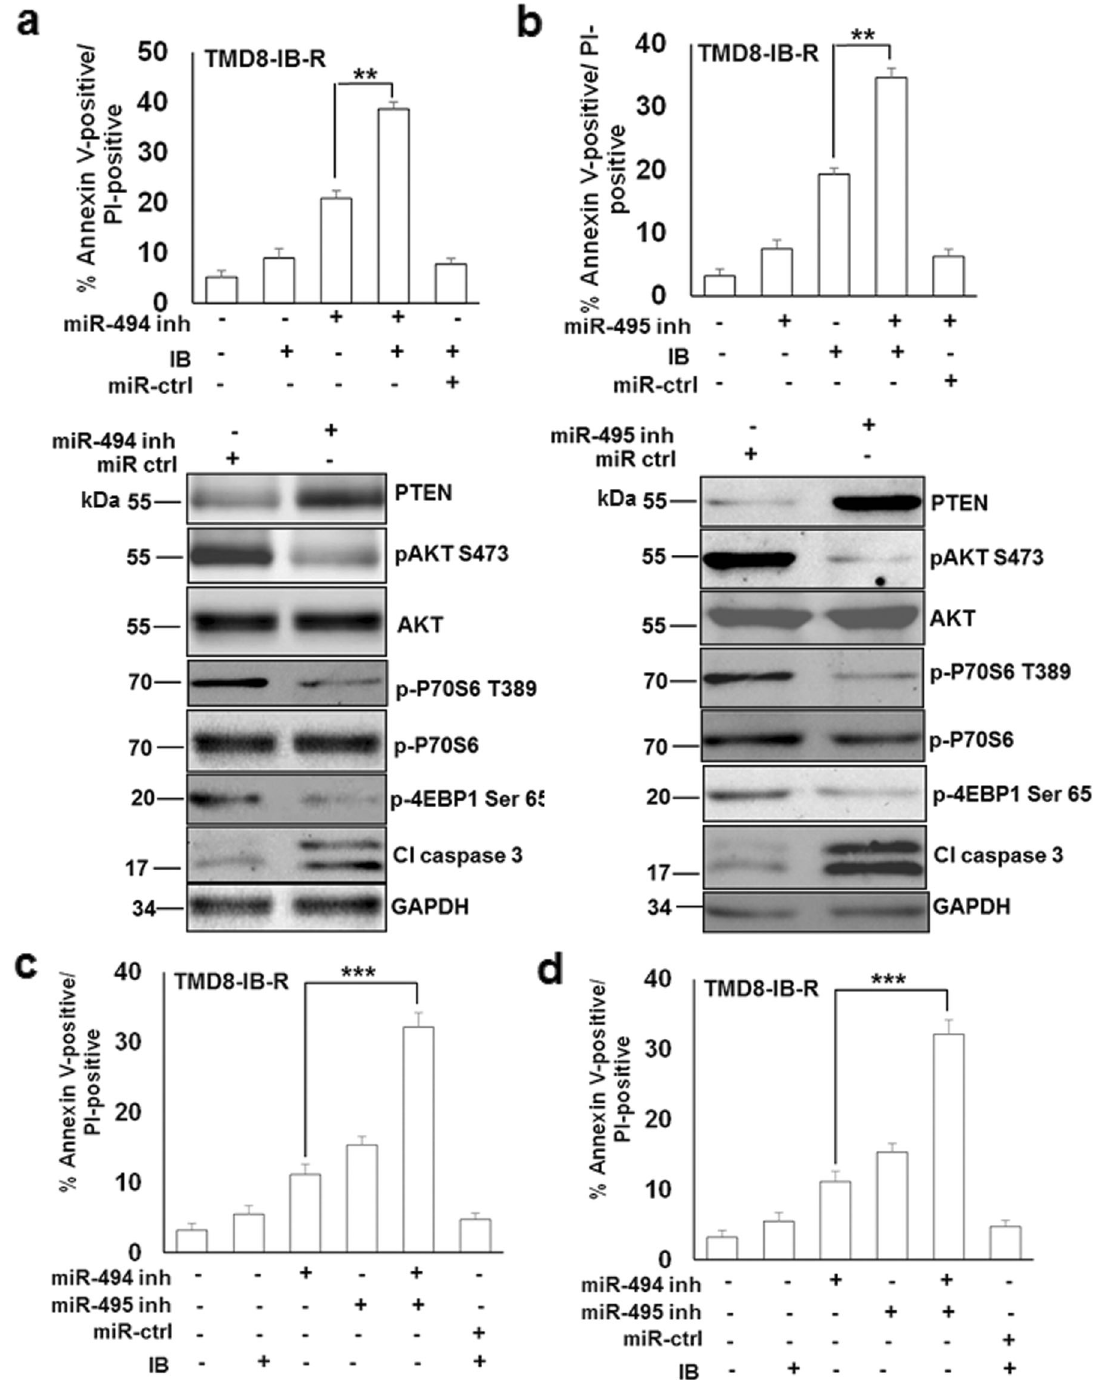
Fig. 6 Cooperative miR-494 and miR-495 inhibition enhances cell survival through AKT/mTOR signaling. a TMD8-IB-R cells were transfected with miR-494 (200 nM) and b miR-495 (100 nM) inhibitors and treated with ± ibrutinib (10 µM) for 24 h. ( Upper panel) Cell death analysis was determined by Annexin V-PI staining. Control cells were treated with DMSO. (**p < 0.01). SD is indicated as error bars ( N = 3). (Lower panel) Expression levels of PTEN, pAKT Ser473, AKT, pP70S6-T389, pP70S6, p4EBP1, and cleaved caspase 3 were determined in whole- cell extracts of TMD-IB-R cells transfected with miR-494 (200 nM) and miR-495 inhibitors, respectively (100 nM) by immunoblotting. GAPDH was used as a loading control. c TMD8-IB-R and d MEC-1-IB-R cells were transfected with miR-494 (200 nM) and miR-495 (100 nM) either alone or in combination for 24 h. Cell death analysis was determined by Annexin V-PI staining. Control cells were treated with DMSO. (*p < 0.05, **p < 0.01). SD is indicated as error bars ( N = 3).